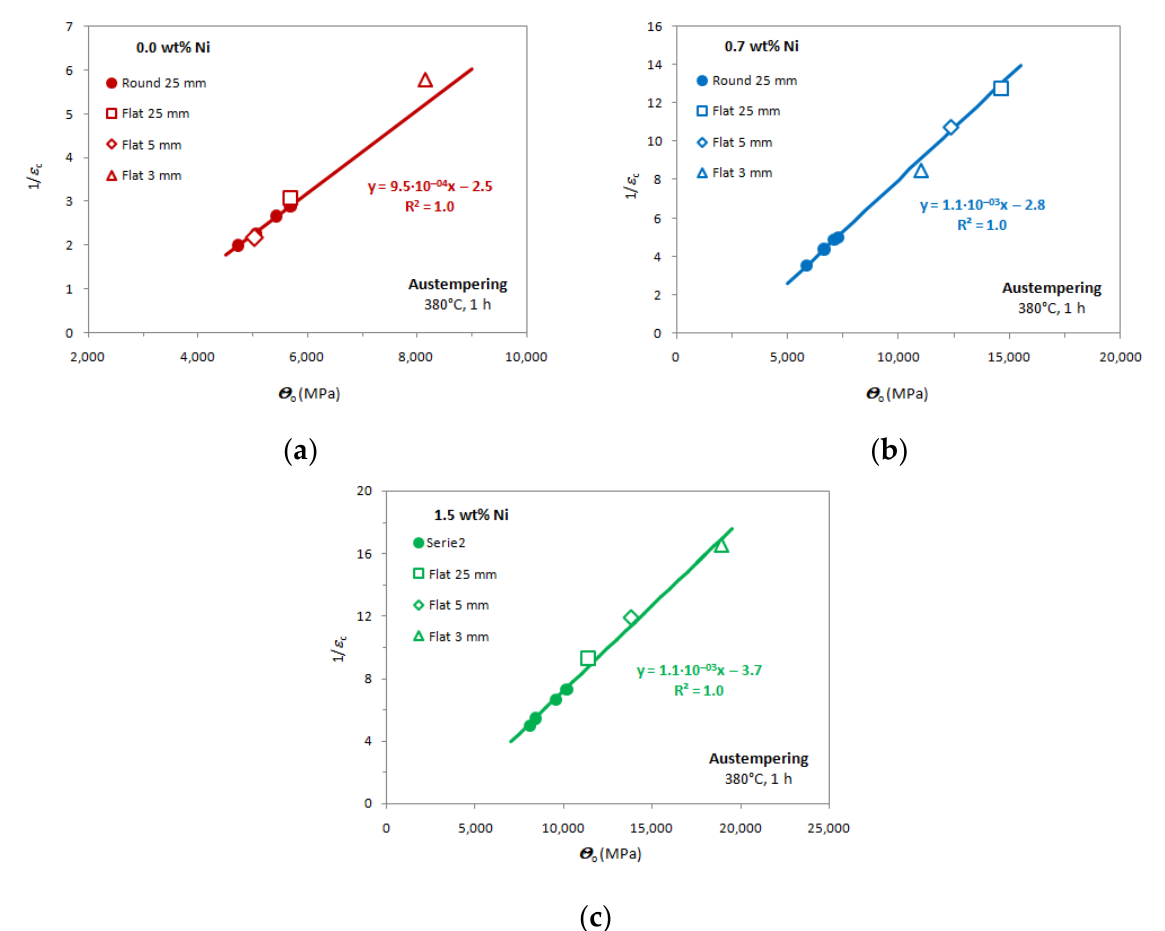
Figure 13. MADs for 25mm Y-block ADIs (round and flat tensile specimens), 5 mm and 3 mm thin castings with austempering conditions 380 °C and 1 h with different Ni content: ( a ) nominal 0.0 wt% Ni; ( b ) nominal 0.7 wt% Ni; ( c ) nominal 1.5 wt% Ni.